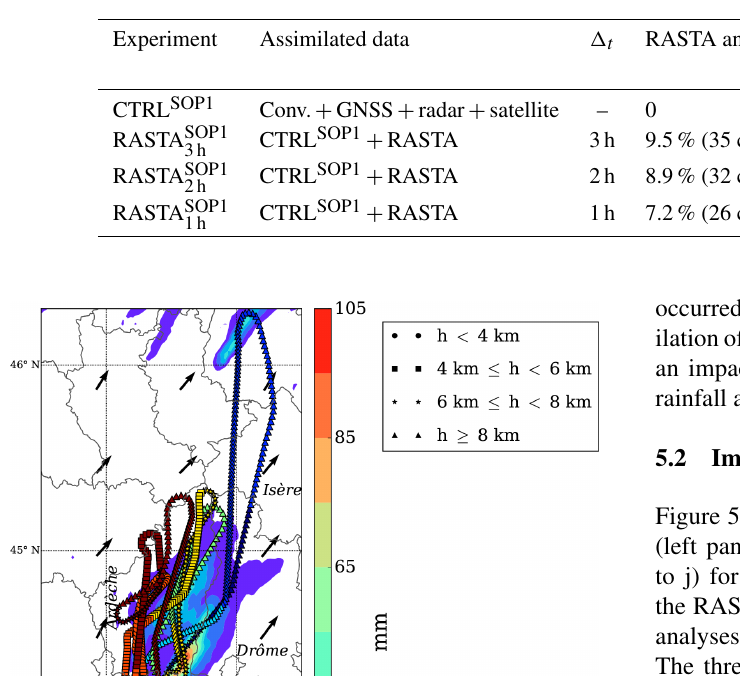
Table 1. Experimental design from 24 September to 5 November 2012.